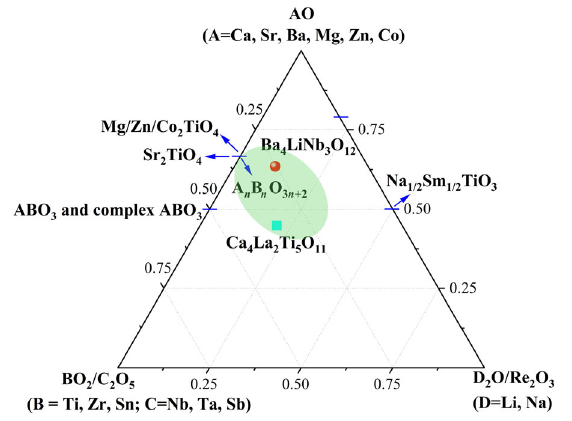
Fig. 18 Pseudo phase diagram of perovskite related